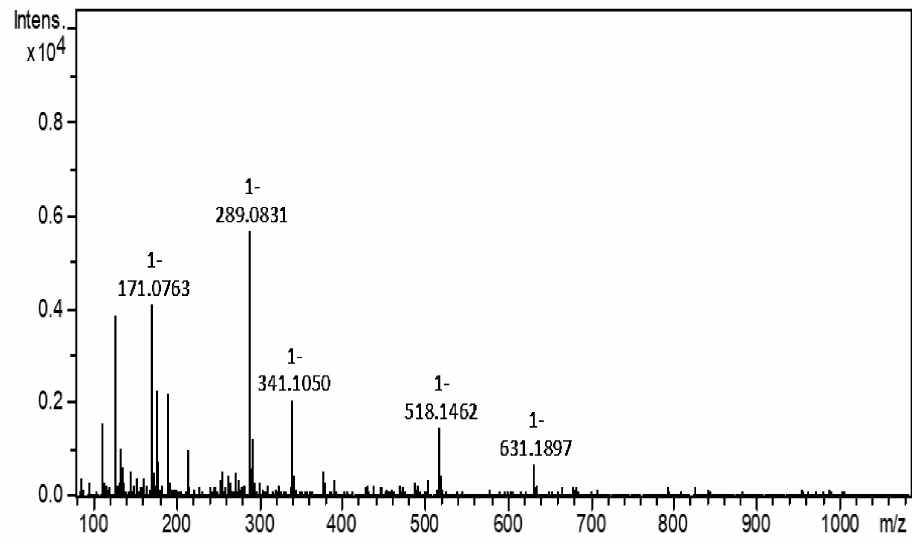
Figure 6. Garlic bulb extract m / z peaks detected in mass spectrometer (in negative mode).